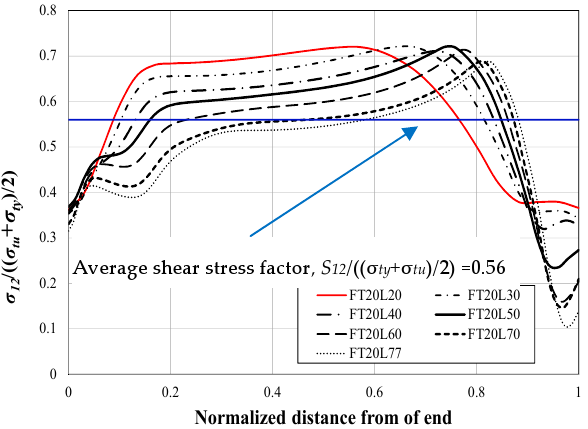
Figure 11. Shear stress distributions along the shear plane (Path 4).